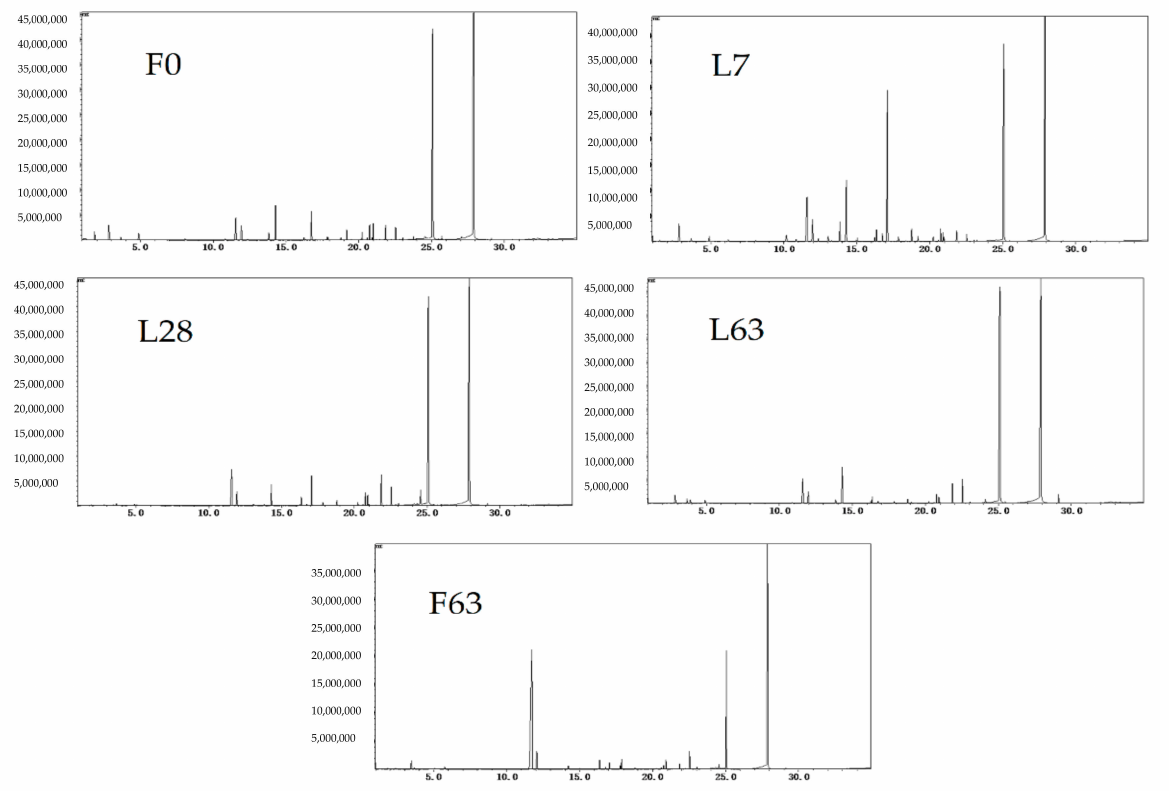
Figure 2. GC-MS total ion chromatogram of the volatile components of noni juice at different fermentation times and